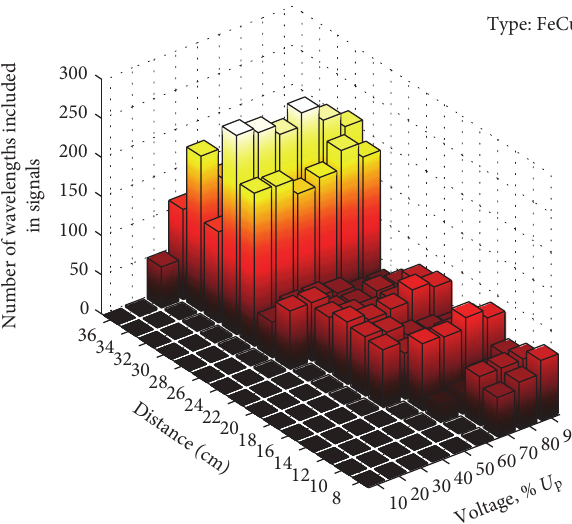
Figure 12: Dependency of voltage and distance on the number of wavelength components for the FeCu line.